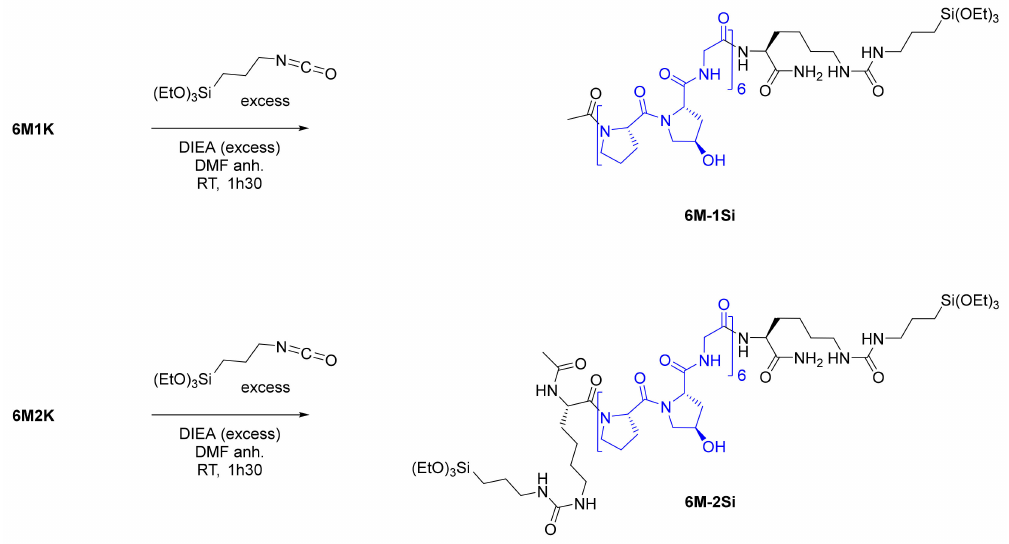
Figure 2. Silylation of 6M1K / 6M2K yielding the 6M-1Si / 6M-2Si hybrid collagen-like peptides. The secondary and tertiary structures of the peptides and their hybrid analogues (200 µ M in water, pH 7.4 at 20 ◦ C) were investigated by a circular dichroism. During the minutes of analysis and without the presence of any catalyst, no condensation reaction occurred. As expected, the CD spectrum of the four compounds showed a poly-proline II (PPII) secondary structure with a positive maximum at 225 nm and a negative maximum at 195 nm. However, this signature reflected only the PPII secondary structure and did not tell us about the collagen triple helix supramolecular assembly (Figure 3b). To decipher that feature, the Rpn (ratio of positive on negative value) corresponding with the ratio of the CD signals at 225 nm over 220 nm, was calculated (Figure 3a). The presence of a triple helix has already been admitted for Rpn values above 0.11 [34,45,46]. We have previously demonstrated that peptides containing three motives were too short to form a triple helix and showed an Rpn value in the range of 0.66 and 0.082 (naked or silylated respectively) [40]. The Rpn of 6M2K was low (0.068) probably because of the two cationic residues flanking the repeated sequence, which might disrupt the triple helix assembly. Once silylated, the Rpn of 6M-2Si increased to 0.099 indicating a higher supramolecular assembly content. The Rpn values of the mono-functionalized 6M1K and 6M-1Si com- pounds were slightly above 0.11 and were consistent with the presence of triple helixes. It is worth noting that higher Rpn values could be obtained by enlarging the peptide sequences (i.e., 7 Pro-Hyp-Gly motives or greater) as reported in the literature [45] but the solubility of such silylated hybrid peptides considerably dropped and did not allow the preparation of the